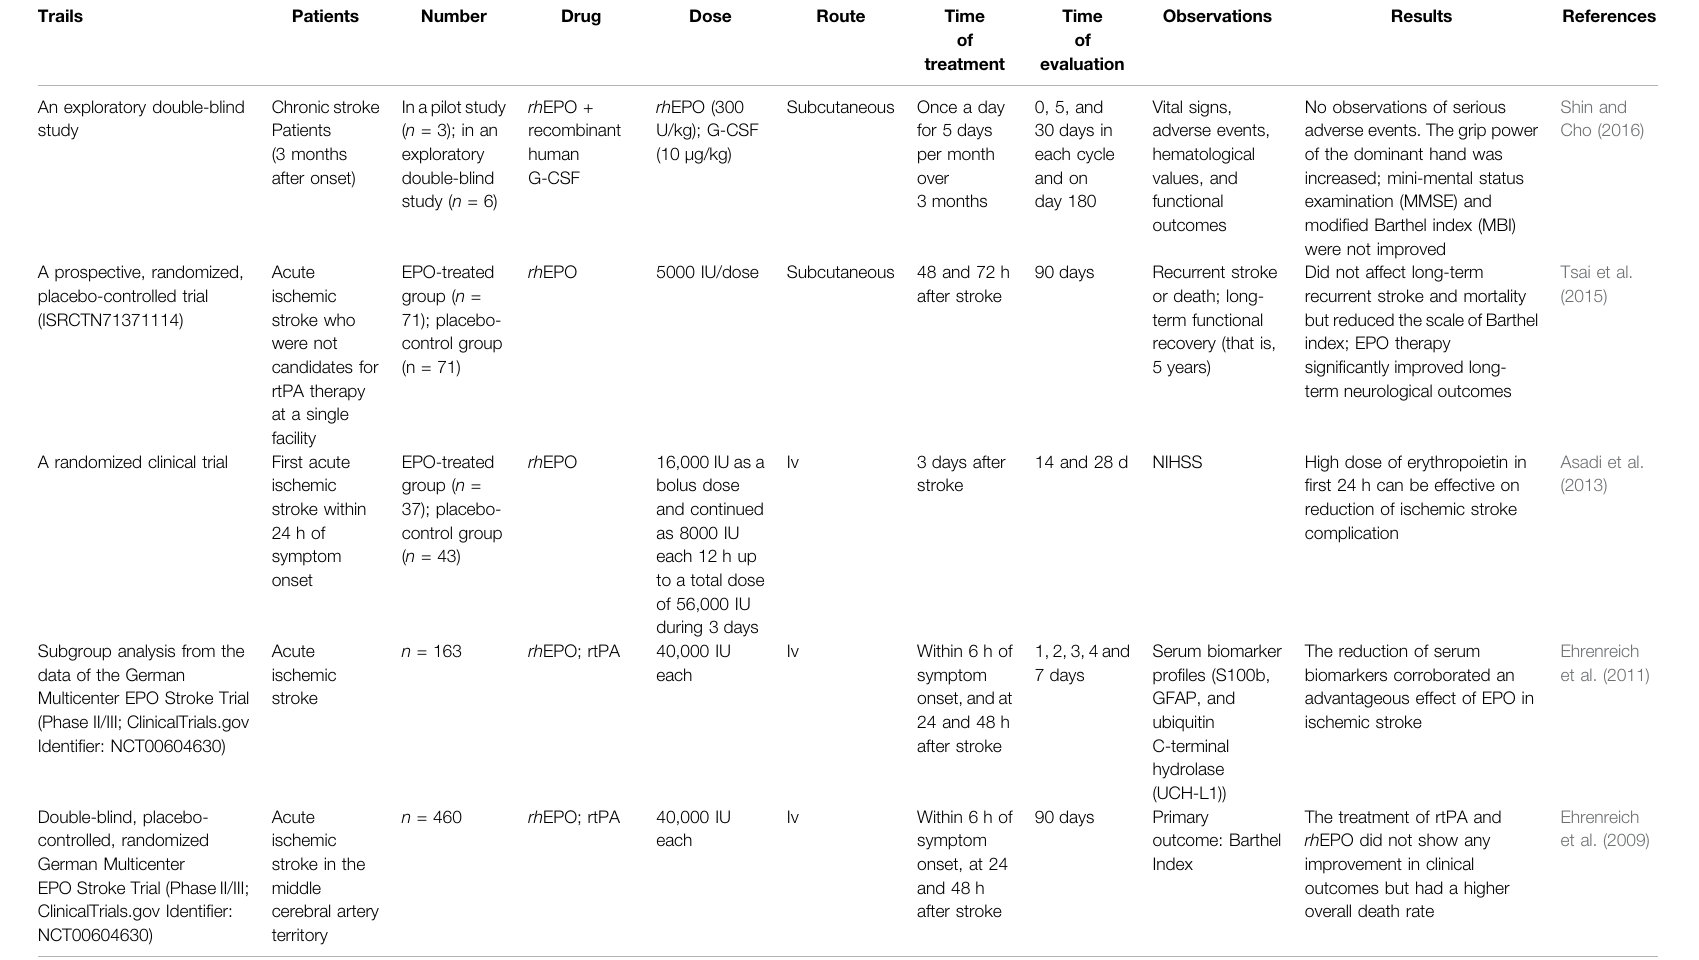
TABLE 1 | Clinical trials of rh EPO treatment for ischemic stroke patients.